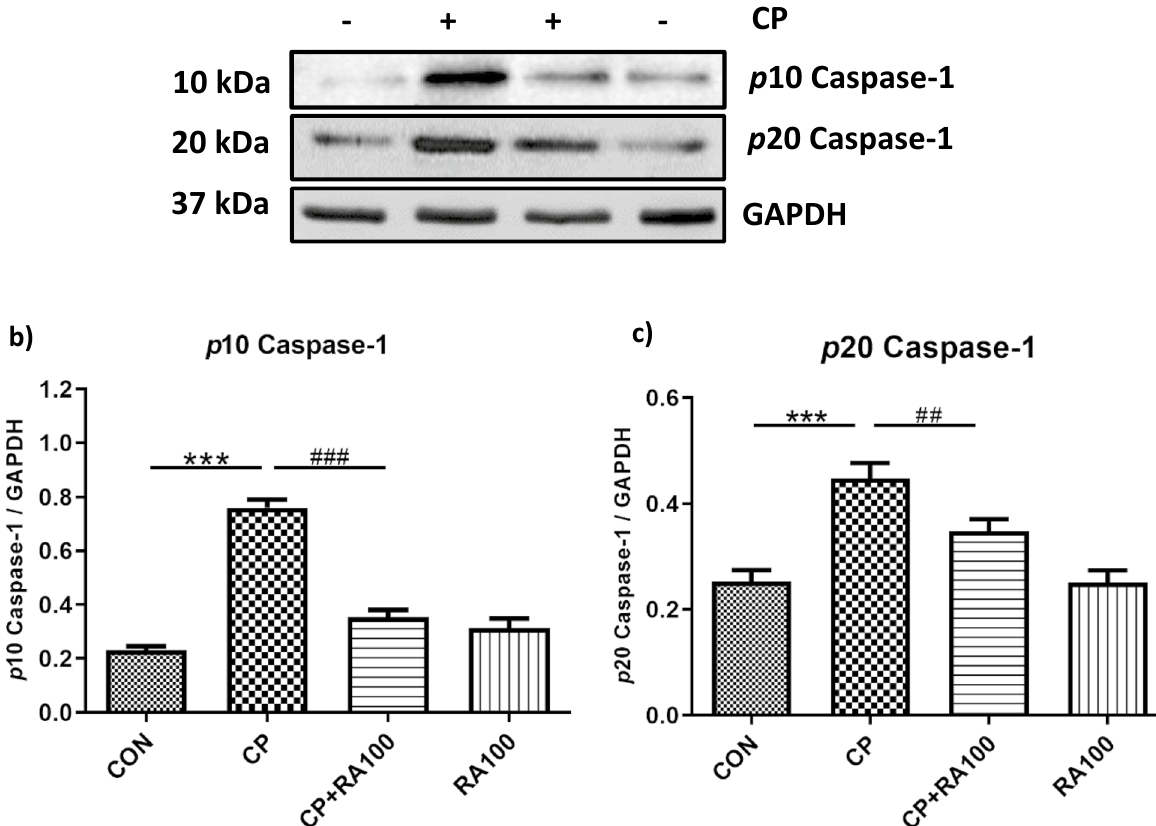
Figure 5. Analysis of activated caspase-1 by western blotting after CP and RA administration in mouse kidney. ( a ) Represents the immunoblots of activated cleaved subunits ( p 10 caspase-1 and p 20 caspase-1) of caspase-1 after CP and RA treatments. The administration of CP caused an increase (dark bands) in the expression of cleaved p 10 caspase-1 and p 20 caspase-1 proteins when compared with control group of animals. While the treatment of RA along with the administration of CP caused a decrease (light bands) in the expression of p 10 caspase-1 and p 20 caspase-1 proteins when compared with the CP alone treated group of mice. Histogram ( b ) and ( c ) represent significant differences between CP and CP + RA100 treated group of animals. The treatment of CP caused a significant increase in the expression of p 10 caspase-1 (*** p < 0.001) and p 20 caspase-1 (*** p < 0.001) proteins when compared with control group of animals. However, the treatment of RA along with CP caused a significant restoration in the expression of p 10 caspase-1 ( ### p < 0.001) and p 20 caspase-1 ( ## p < 0.01) proteins when compared with CP alone treated group of mice. No significant differences were noticed in RA alone treated group of animals when compared with control group of animals. Data are expressed as means ± SEM ( n =